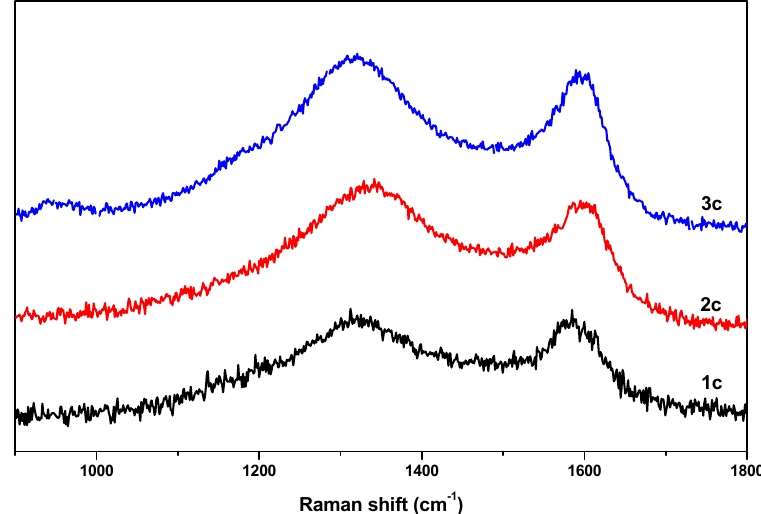
Figure 6. Raman spectra of the obtained nanoporous carbon samples.